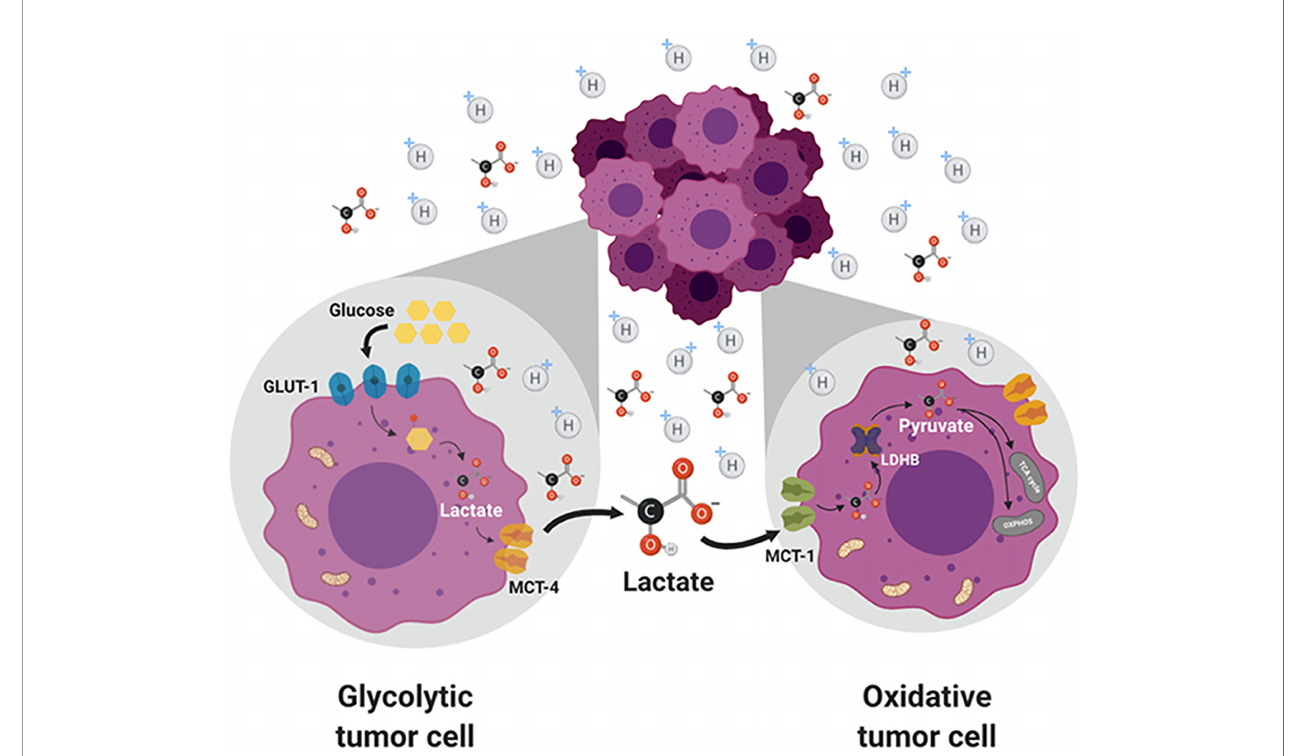
FIGURE 3 | Lactate exchange between the glycolytic tumor cells present in the hydrophobic core and the oxidative tumor cells. Lactate transported out of the glycolytic cells is taken up by the oxidative cells and used for energy production. Figure licensed under CC BY, copyright © 2019 de la Cruz-Lo ́ pez, Castro-Muñoz, Reyes- Herna ́ ndez, Garc ı ́ a-Carranca ́ and Manzo-Merino. Lactate in the Regulation of Tumor Microenvironment and Therapeutic Approaches. Front Oncol. 2019 Nov